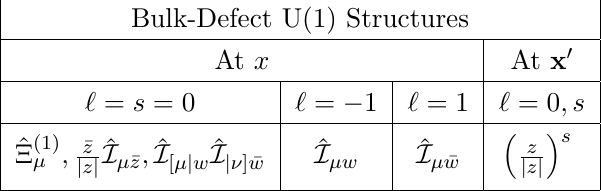
Table 1 . The tensor structures necessary for building bulk-defect two-point functions, along with their transformation properties with respect to the parallel and transverse SO(2) rotation groups; ‘ is used for the parallel directions and s for the transverse ones. The bulk indices are µ and ν . The defect indices are w and ¯ w along the defect and z and ¯ z transverse to it. More details on the tensor structures can be found in